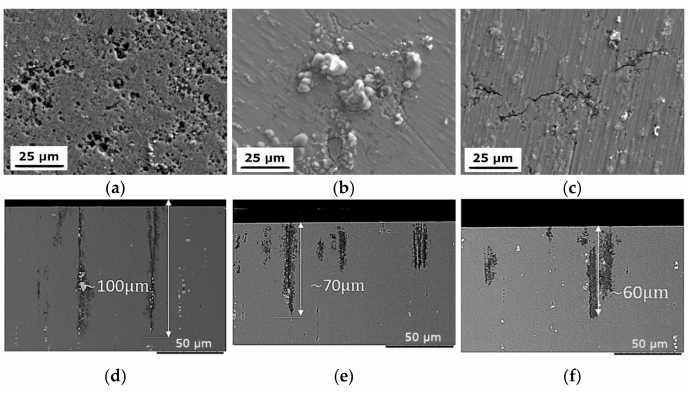
Figure 15. SEM micrographs of the surfaces of: ( a ) CG T6, ( b ) HE10, ( c ) HE8 and cross-sections of ( d ) CG T6, ( e ) HE10, ( f ) HE8 samples. 50 µ